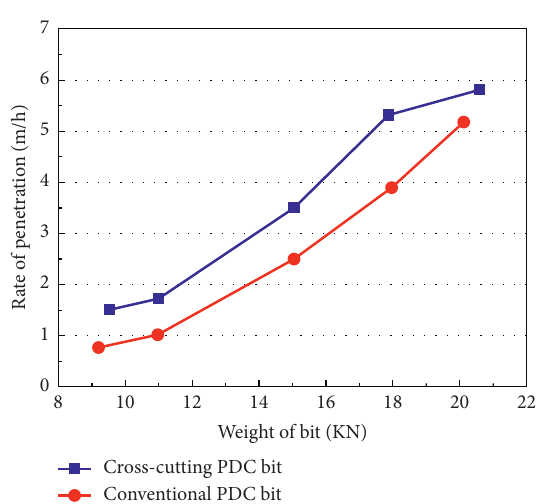
Figure 24: Relationship between WOB and ROP during drilling sandstone.